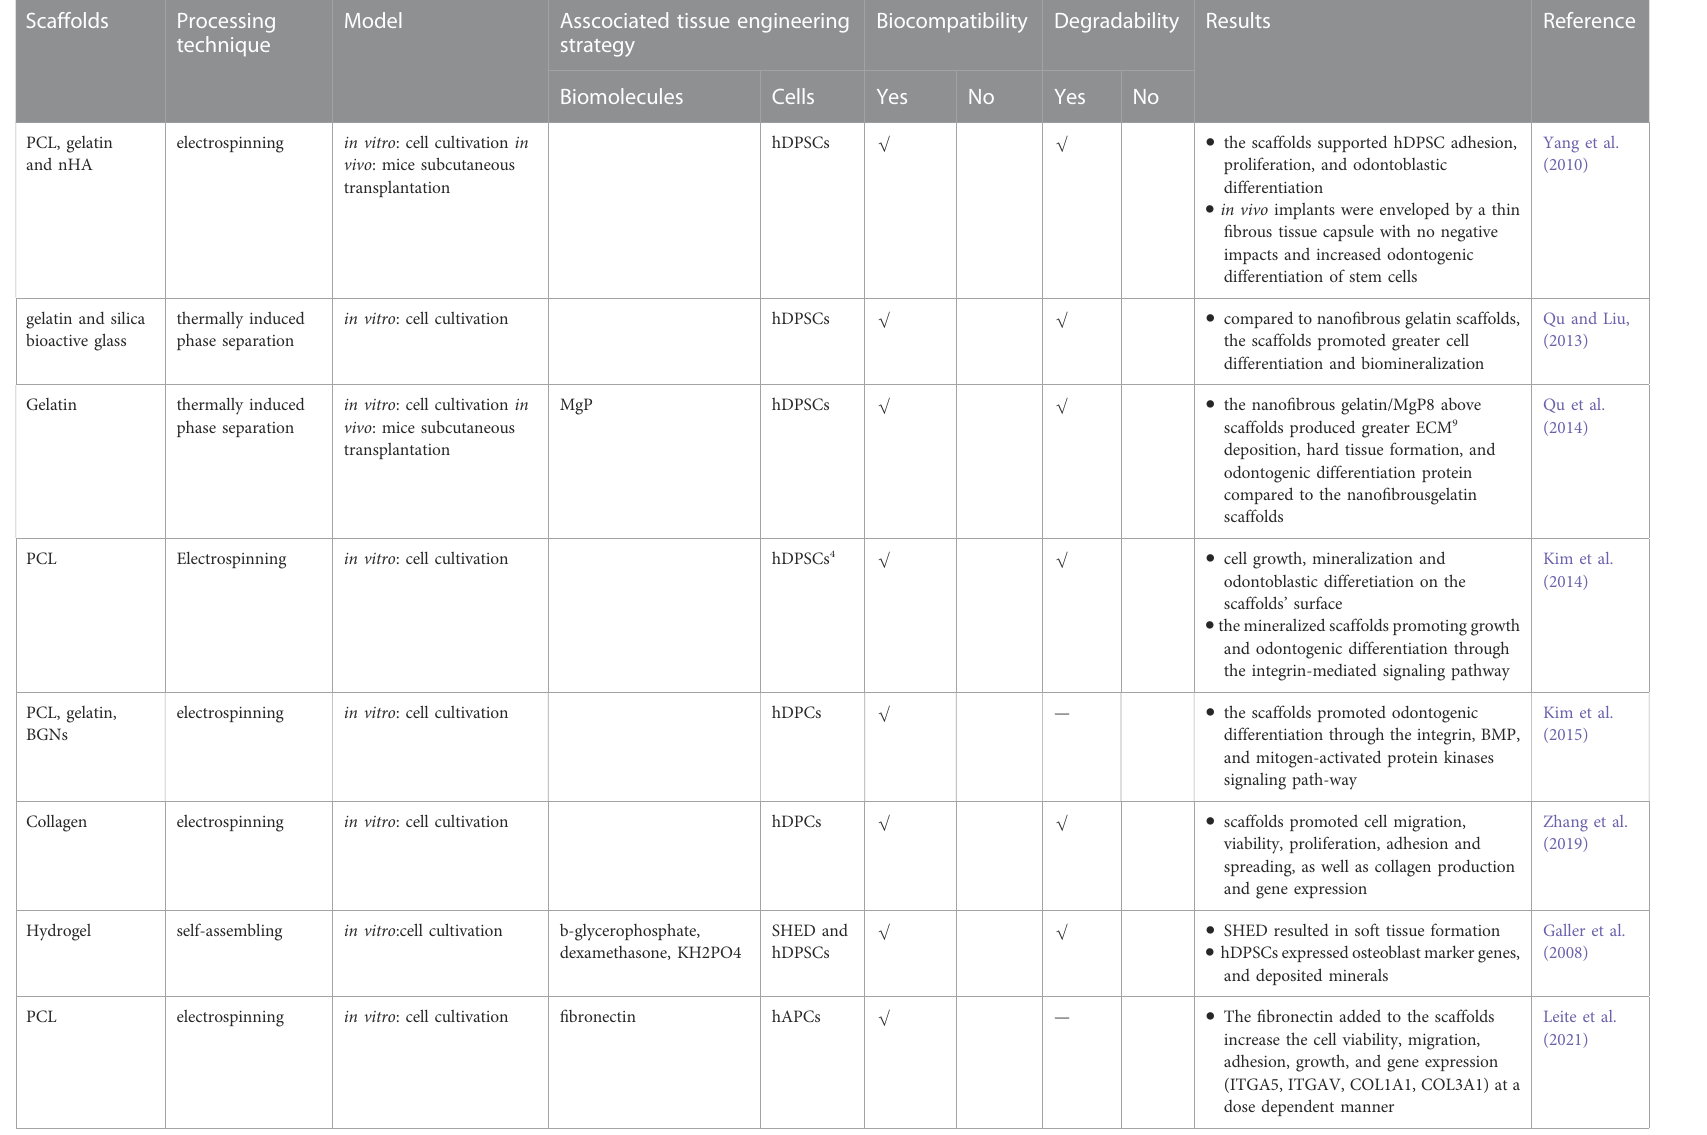
TABLE 2 Nano fi brous scaffolds for pulp connective-tissue and dentin formation.